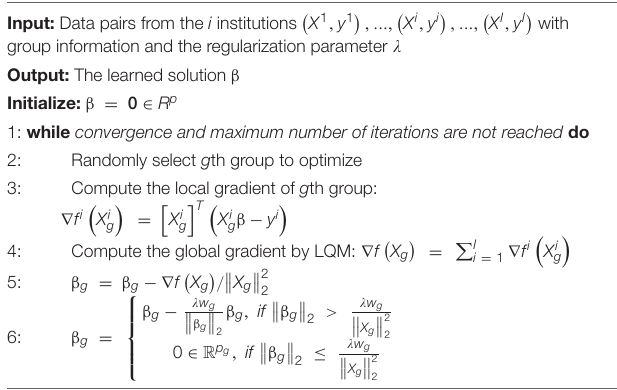
ALGORITHM 1 | Federated block coordinate descent